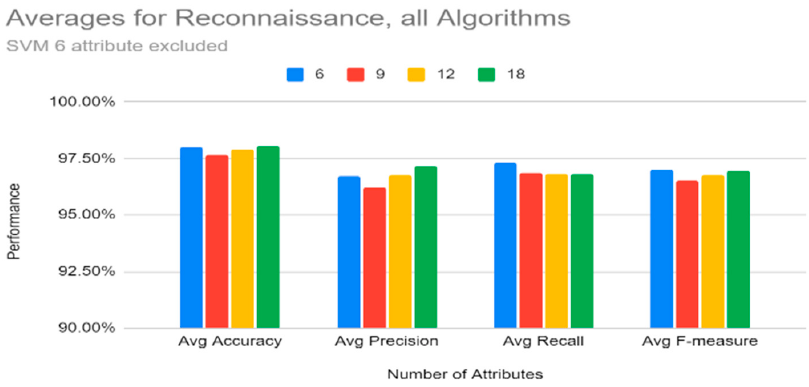
Figure 13. Reconnaissance: Averages for All Algorithms by Number of Features (SVM’s six attributes excluded).